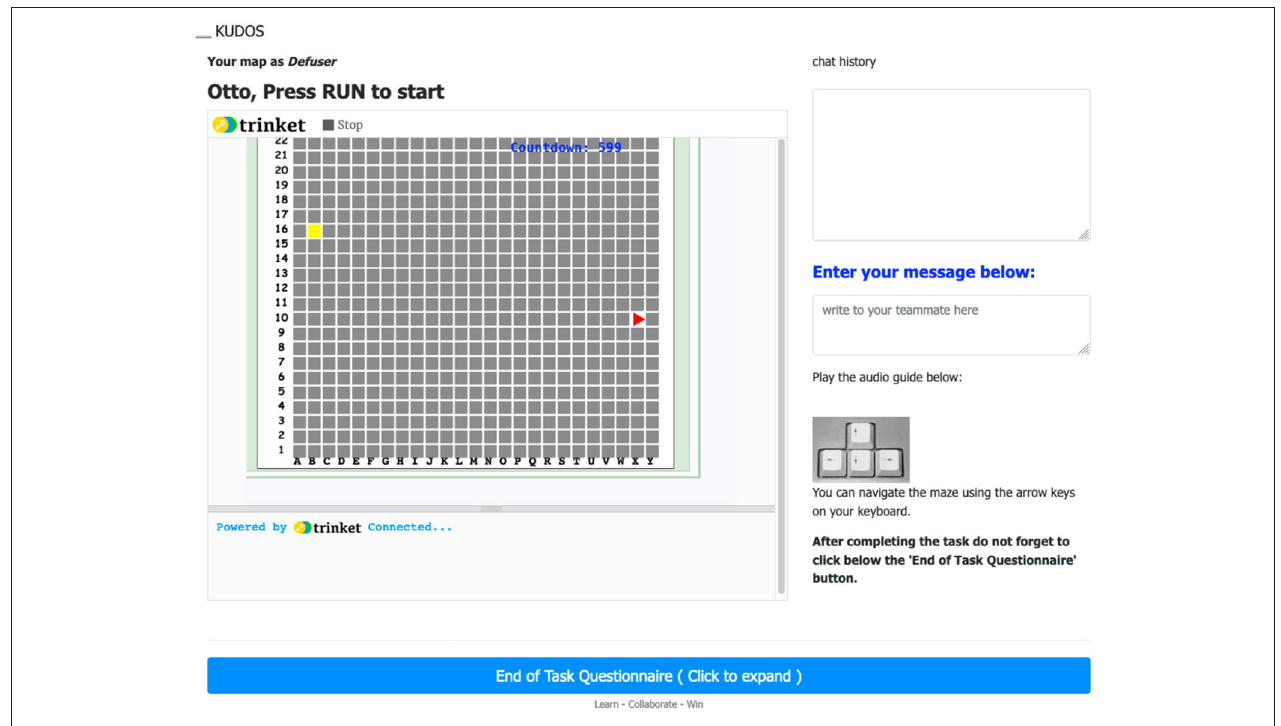
FIGURE 2 | Defuser’s view of the maze. The maze did not indicate the path to the bomb (red triangle), nor the walls. The participant was prompted to get directions from the Lead Expert through a chatbox (top-right of the screen).